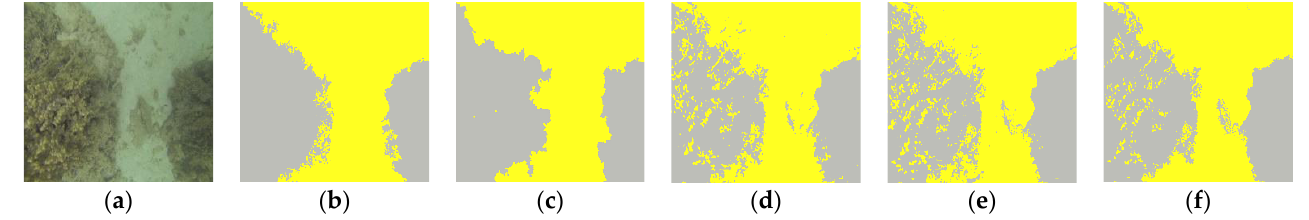
Figure 23. Validation tests of the proposed segmentation algorithms using highly illuminated and low contrast coral image (1) from Figure 21 as example of two categories: ( a ) original image; ( b ) ground truth image; ( c ) FF result; ( d ) FR result; ( e ) OS result; ( f ) KM result. Gray: corals and yellow: sediments.